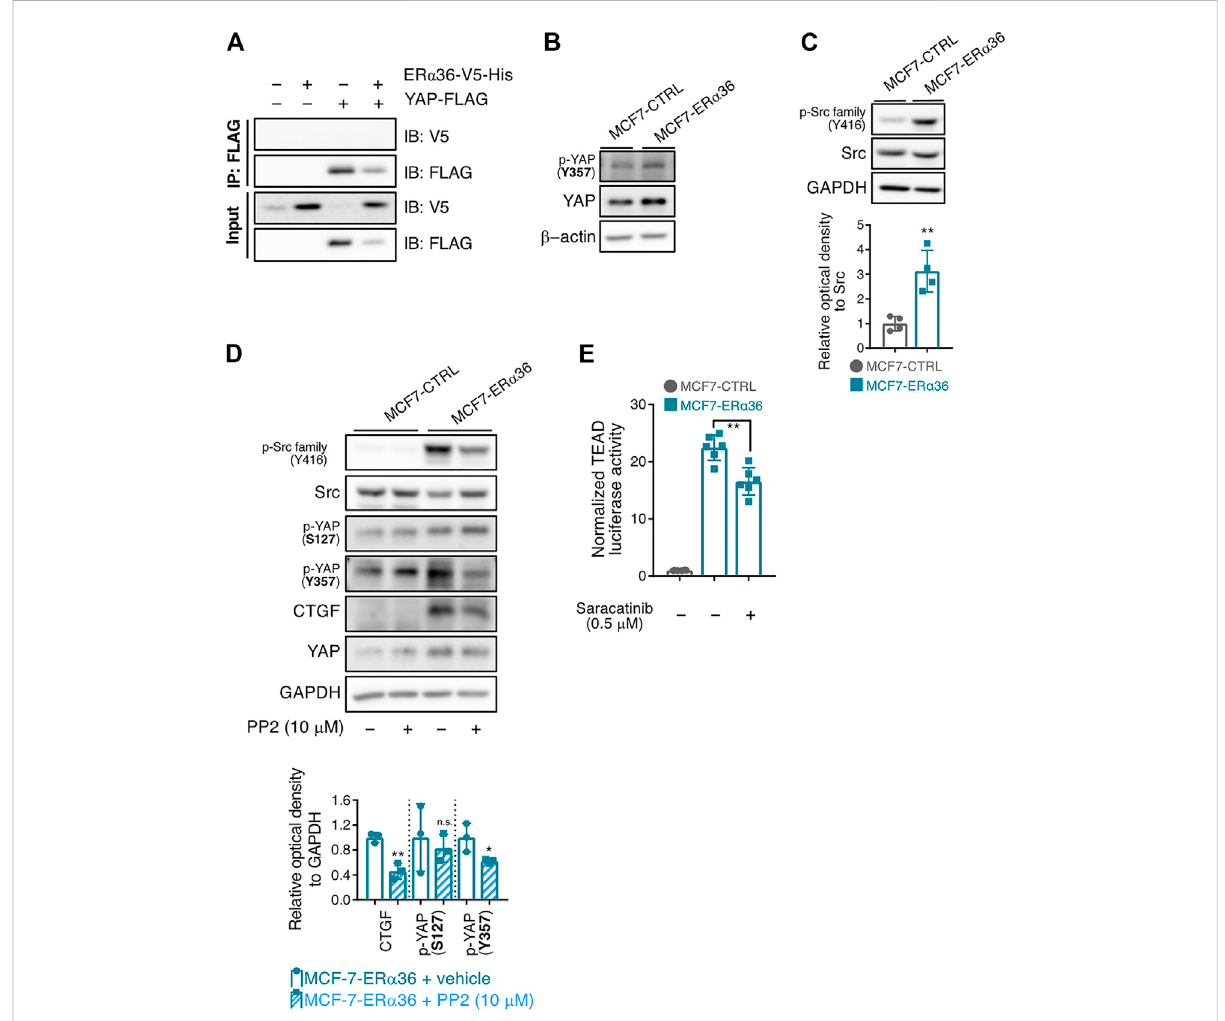
FIGURE 4 RoleofSrcintheER α 36-inducedYAPactivation. (A) ImmunoprecipitationandimmunoblottingofV5andFLAGproteinsinMCF-7-MSCV-CTRL and MCF-7-MSCV-ER α 36-V5-His cells. (B) Increased expression of p-YAP (Tyr357) protein in MCF-7-ER α 36 cells compared to MCF-7-CTRL. (C) Expressionofp-Srcfamily(Tyr416)andSrcintheindicatedcells(up)andtherelativeopticaldensityofp-Srcprotein(down). (D) EffectofPP2(10 μ M, 24 h),aSrcfamilykinaseinhibitorontheexpressionlevelofeachindicatedproteininMCF-7-CTRL andMCF-7-ER α 36cells(up)andtherelative optical density of them (down). (E) TEAD reporter activities in MCF-7-ER α 36 cells treated with saracatinib, a Src inhibitor for 24 h. All statistical signi fi cance of the differences was determined by unpaired two-tailed Student t test. n. s., not signi fi cant; *, p < 0.05; **, p < 0.01; signi fi cant as compared with MCF7-CTRL cells (C) or vehicle-treated cells (D – E)